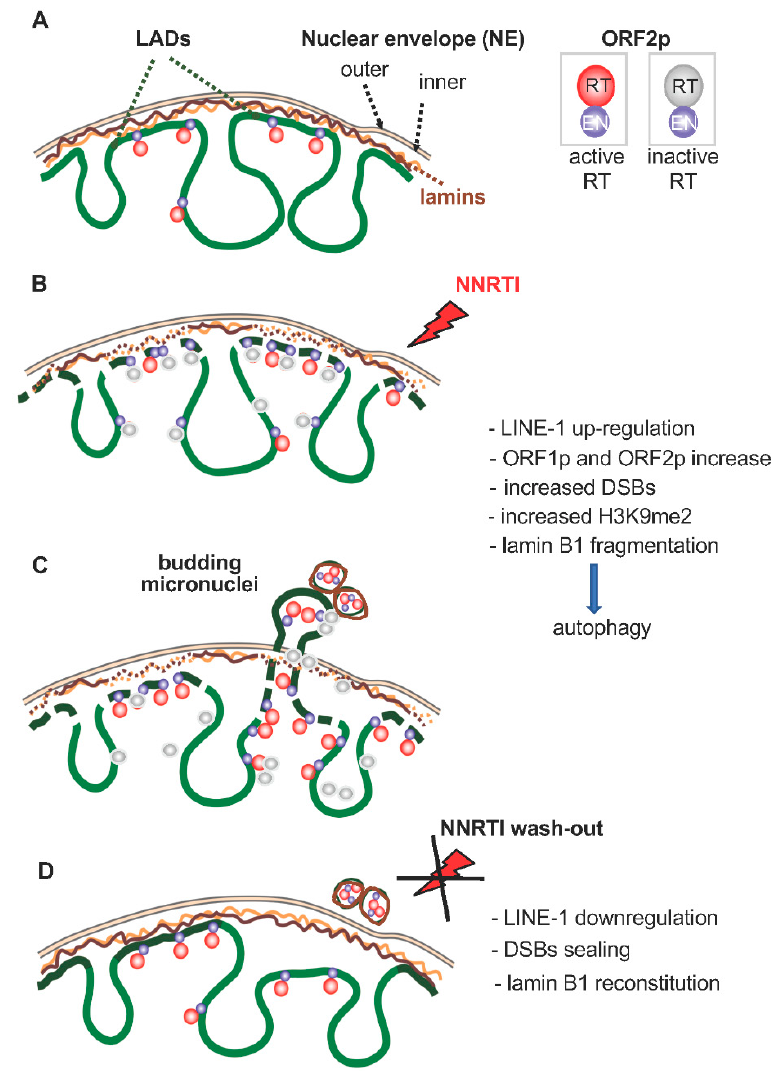
Figure 2. A hypothetical model for LINE-1 -mediated chromatin remodeling. ( A ) A simplified representation of chromatin–lamin interactions. LADs: lamin-associated domains of chromatin. Chromatin is schematized in green. For simplicity, the nuclear envelope (NE) is represented without nuclear pores. ( B ) NNRTIs act as stressing stimuli (red flash): in response, LINE-1 products ORF1p and ORF2p are upregulated, the DNA is cleaved (DSBs, double strand breaks), lamin B1 is fragmented, and autophagy is activated. ( C ) DSBs and lamin B1 fragmentation increase chromatin plasticity and remodeling. Concomitantly, DNA- and lamin B1-containing micronuclei form, are encircled by the NE, and released outside nuclei. ( D ) After the removal of the NNRTI stress, the nuclear structure is stabilized in a remodeled conformation, driving the formation of novel genomic circuits.